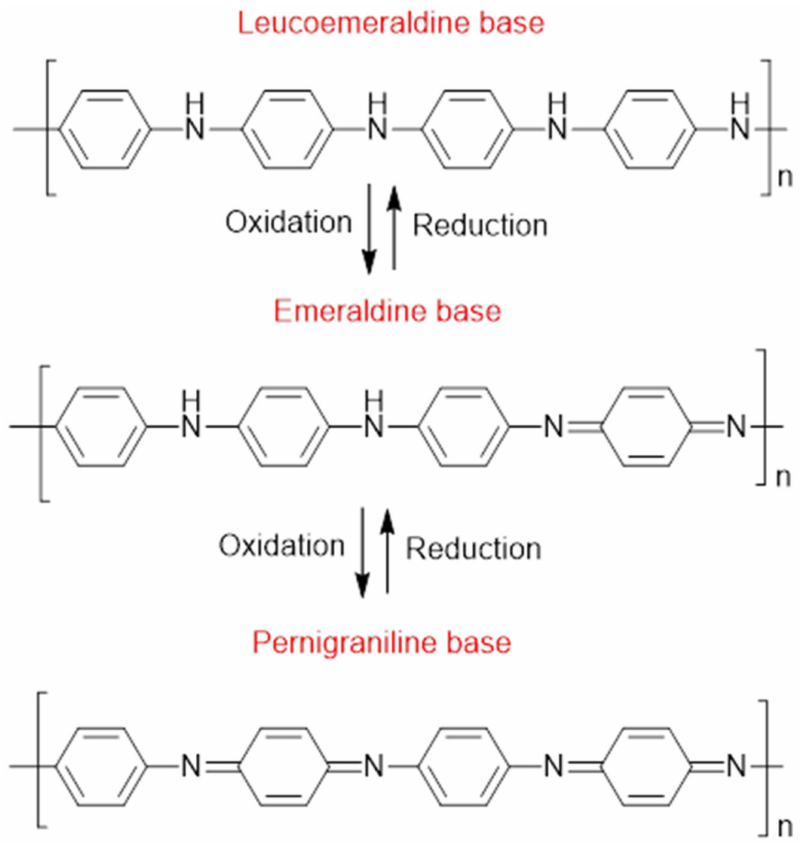
Figure 1. Molecular structure of PANI in variable oxidation states: leucoemeraldine (LE), emeraldine base (EB), and pernigraniline (PG)